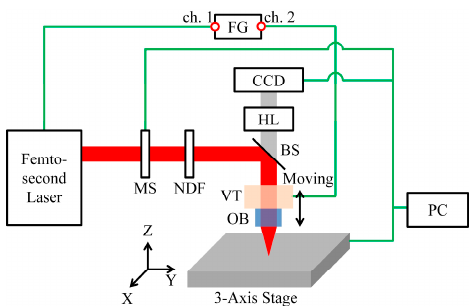
Figure 1. Schematic of the vibration-assisted femtosecond laser machining system. (MS: Mechanical shutter, NDF: Neutral density filter, BS: Beam splitter, VT: Vibrator, OB: Objective lens, CCD: Camera, HL: Halogen lamp, FG: Function generator).